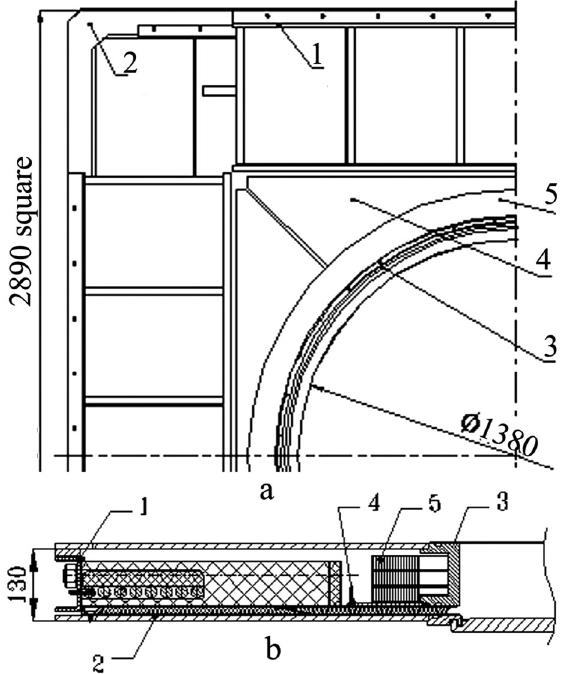
FIG. 4. LTD-20 stage design: (a) top view of one quarter of the stage; (b) partial cross section through central axis. Here are: 1—module of the LTD stage; 2—basement plate; 3—support ring; 4—combined electrodes; 5—stage inductor core (all dimensions are given in mm).